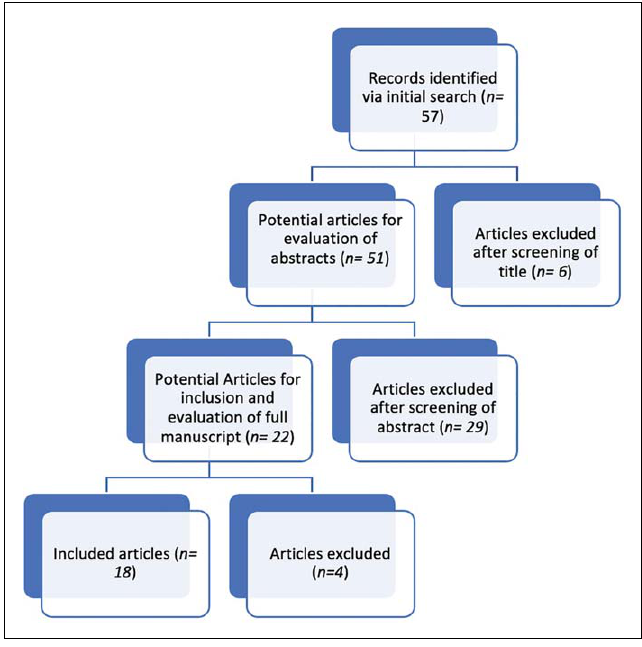
Figure 1. PRISMA flowchart of the included